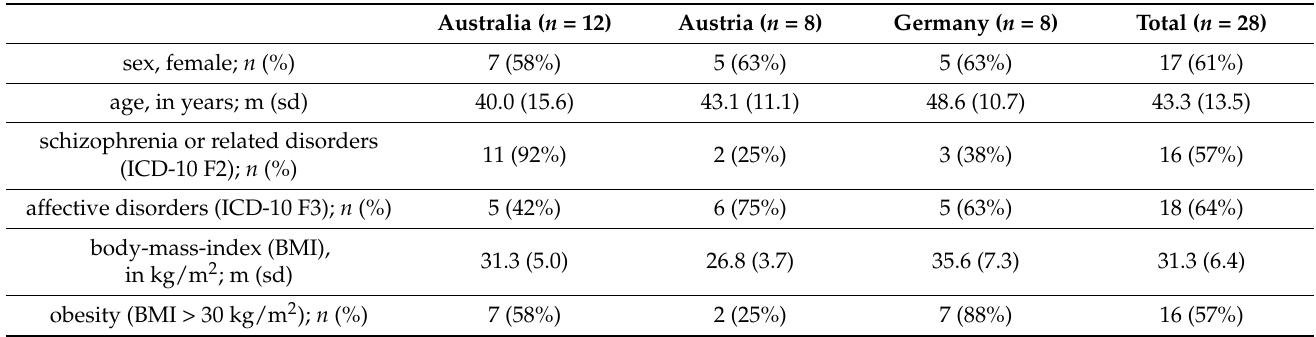
Table 1. Description of the study population (m = mean, sd = standard